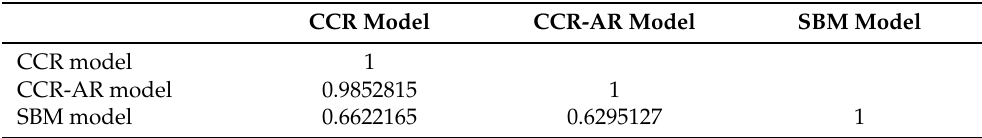
Table 4. Correlation of the efficiency scores in CCR, CCR-AR, and SBM